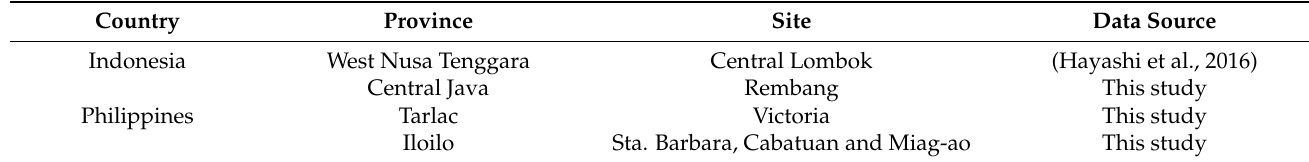
Table 1. Detailed information of the field surveys.